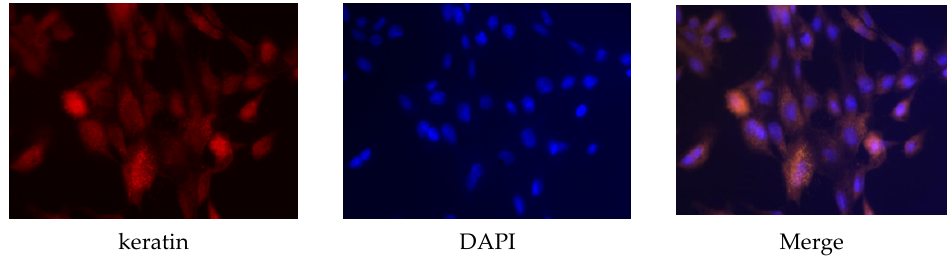
Figure 1. Identification of sow mammary gland cells. Immunocytochemistry was used to identify the cells. The magnification scale was 400×.